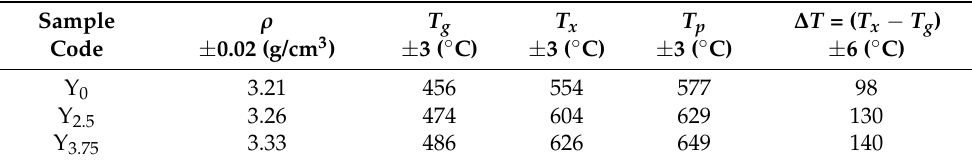
Table 1. The physical and thermal properties of the glasses. Density ρ , glass transition temperature T g , onset of the crystallization temperature T x , crystallization temperature T p , and supercooled liquid region ∆T.